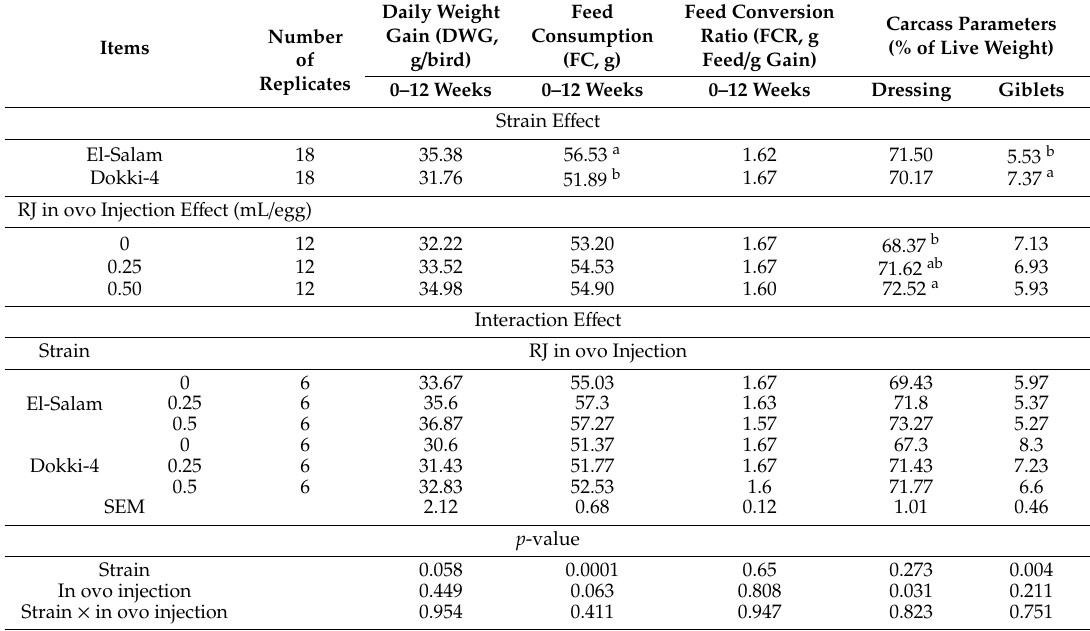
Table 2. E ff ect of in ovo injection of royal jelly (RJ) at two levels (0.25, 0.5 mL / egg) on growth performance and carcass parameters of two chicken strains (El-Salam, Dokki-4) as compared to counterpart control chicks (0 mL / egg) and the interaction of strain and treatment